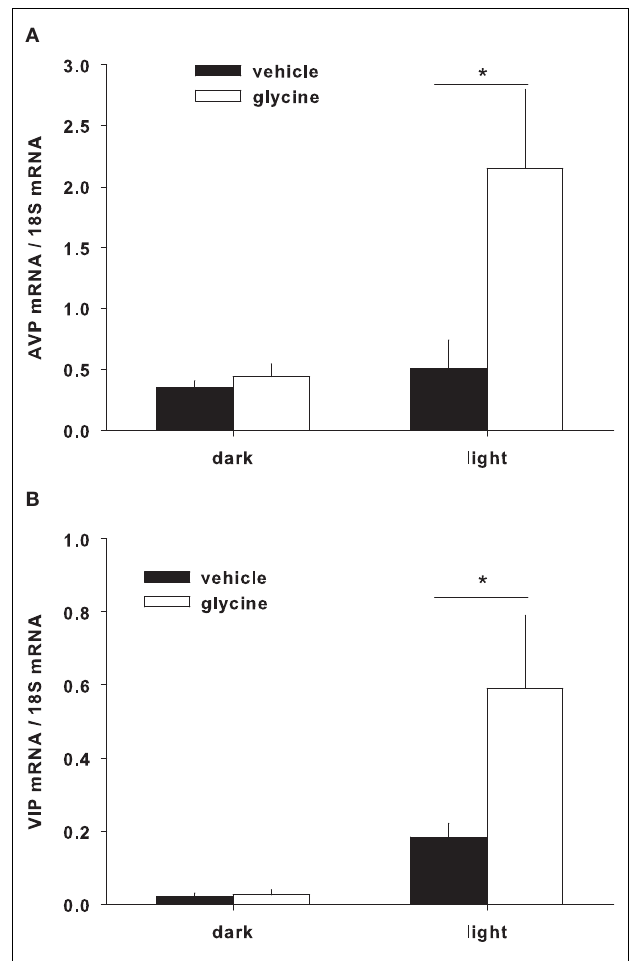
FIGURE 4 | Gene expression in the SCN. The expression of AVP (A) and VIP (B) were significantly increased during the light period after glycine